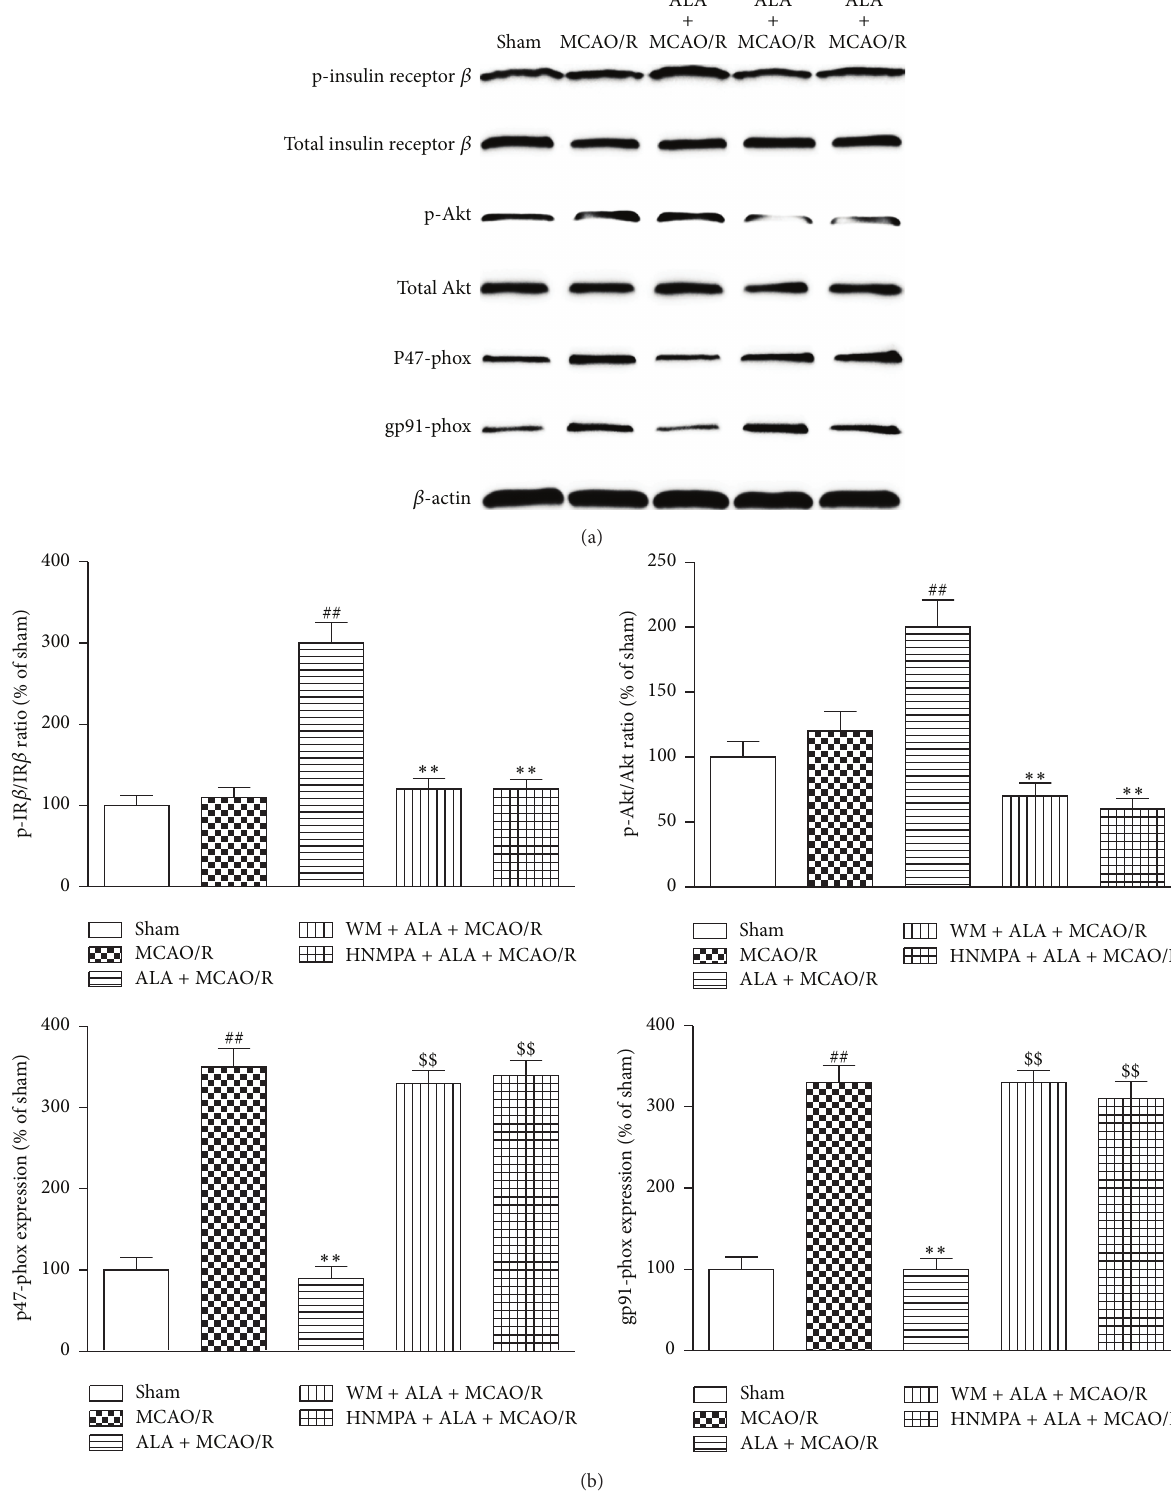
Figure 3: ALA inhibited NADPH oxidase through activation of insulin receptor and PI3K/Akt signaling. (a) The expression of p-insulin receptor, total insulin receptor, p-Akt, total Akt, p47-phox, and gp91-phox. (b) Quantitative analysis of the expression of proteins. For the ALA + MCAO/R group, ALA (40 mg/kg, i.p.) was daily administered to rats for 3 days. For the sham and MCAO/R groups, the rats were given the same amount of ethanol. Data were expressed as means ± SEM. ## 𝑃 < 0.01 compared with the sham group. ∗∗ 𝑃 < 0.01 compared with the MCAO/R group. $$ 𝑃 < 0.01 compared with the ALA + MCAO/R